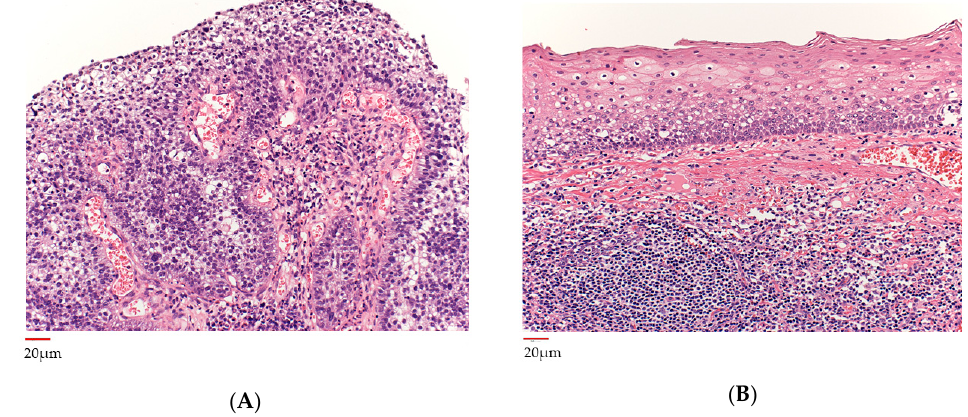
Figure 4. Histopathological findings of the primary tumor. ( A ) Biopsy specimen of primary tumor before neoadjuvant chemotherapy showing papillary proliferation in squamous epithelium around vascular connective tissue and nuclear atypia, diagnosed as squamous cell carcinoma. There is no obvious stromal infiltration. The subepithelium shows inflammatory cell infiltration. ( B ) Surgical